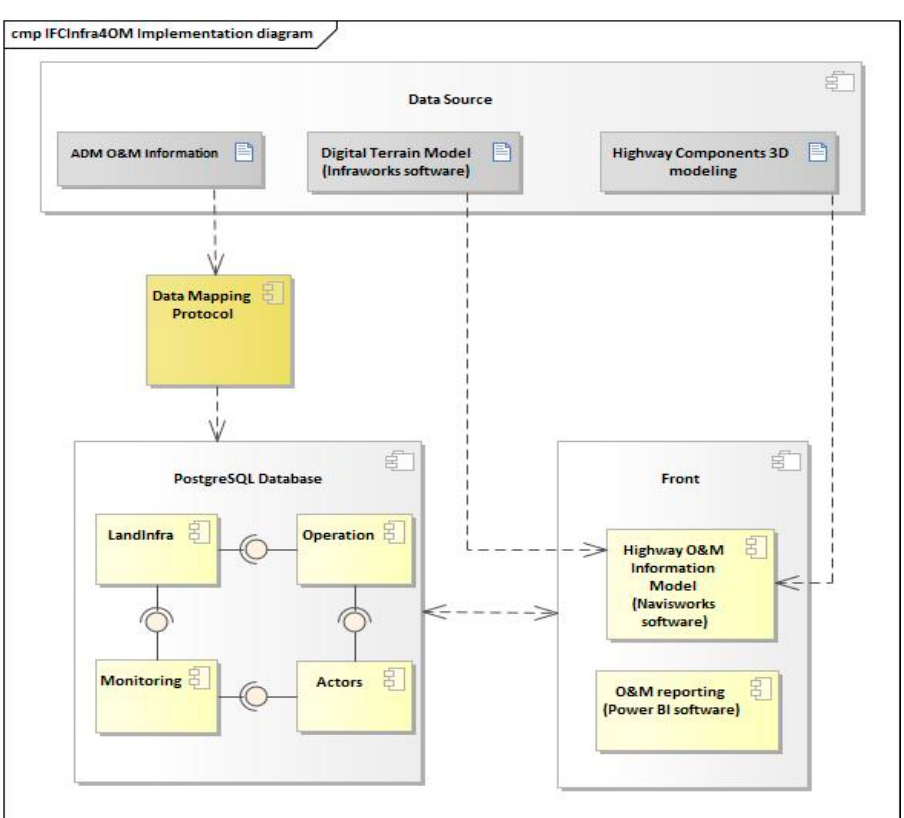
Figure 10. IFCInfra4OM Case Study Implementation Diagram.